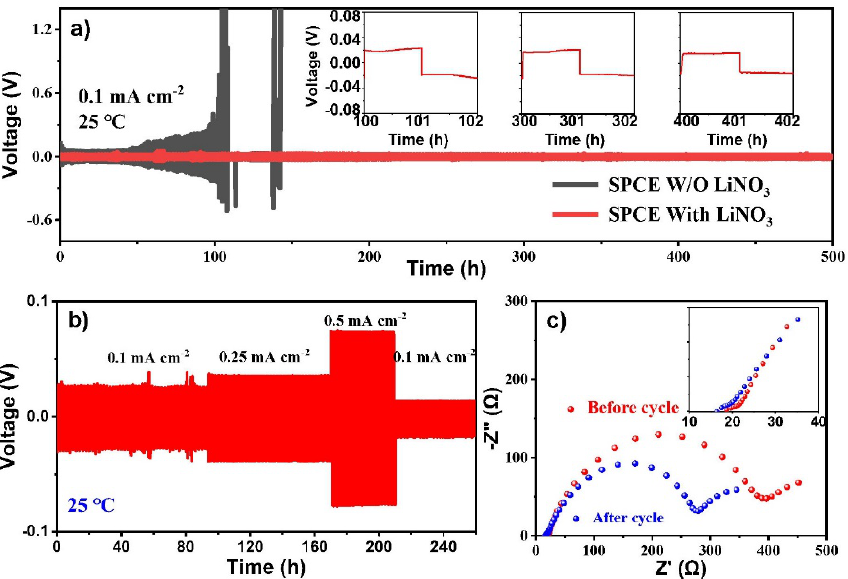
Figure 5. Electrochemical performance of Li|SPCE|Li cell. ( a ) Cycling curves of SPCE with and